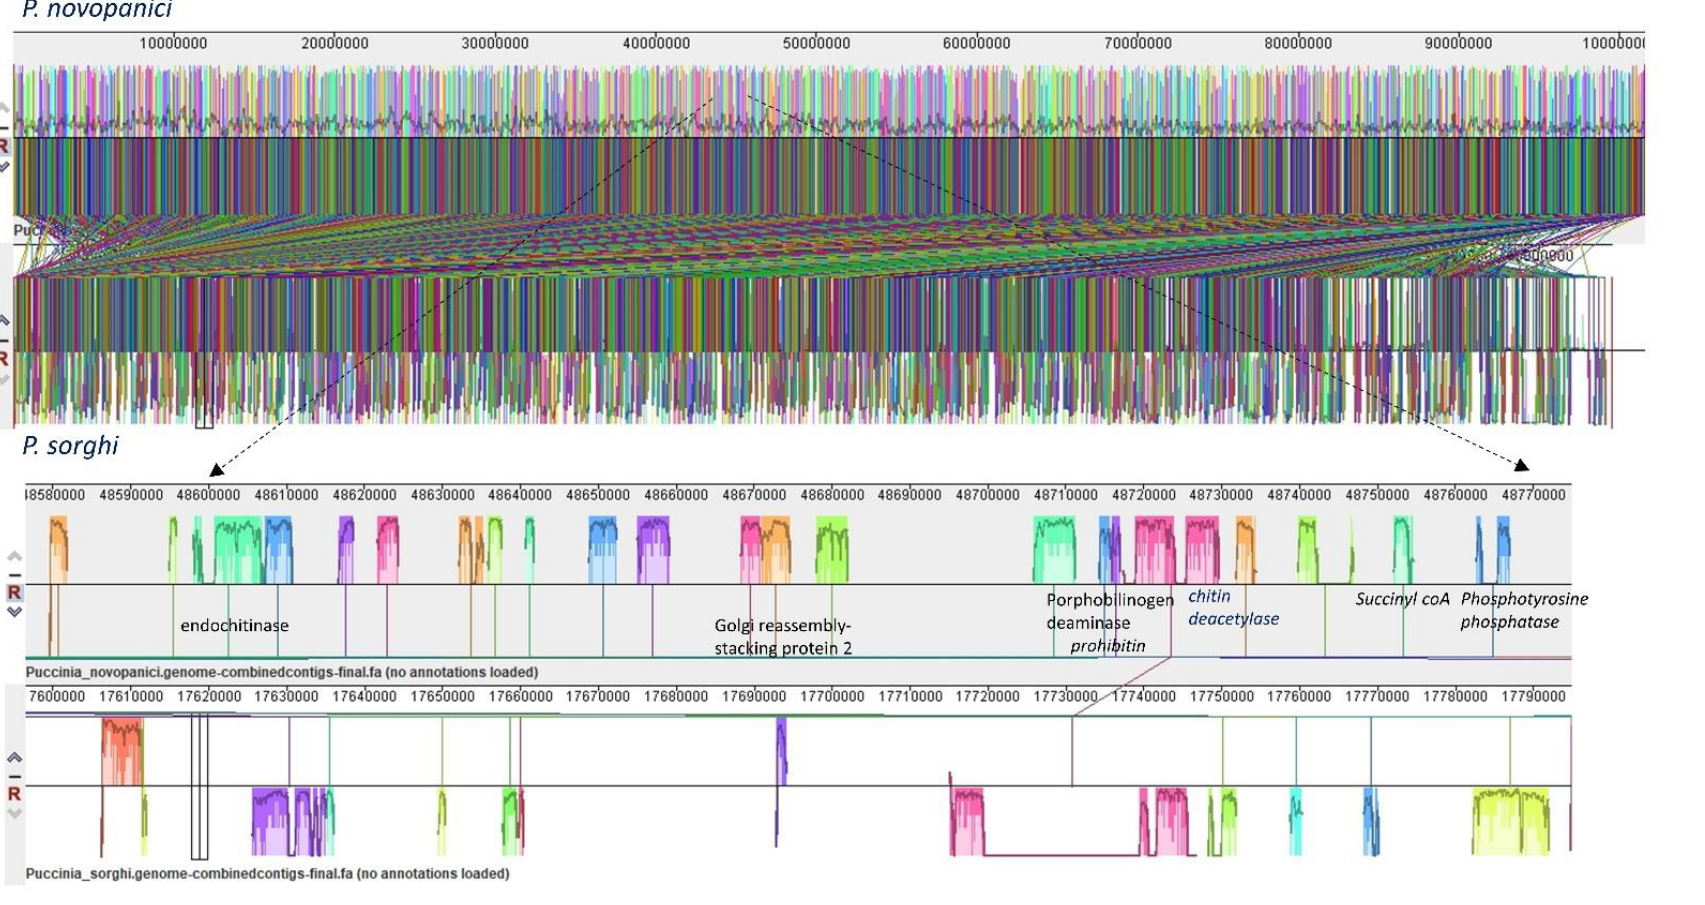
Figure 3. Synteny plots of P. novopanici genome with other Puccinia genomes . Figures represent synteny dot plots generated by D-GENIES ( http://dgenies.toulouse.inra.fr/, accessed 28 June